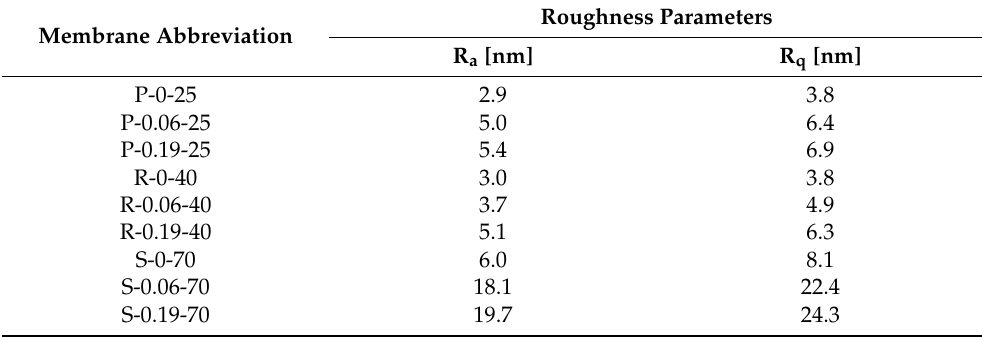
Table 4. Surface roughness parameters of the selective layer surface of PPSU and nanocomposite PPSU/O-MWCNT ultrafiltration membranes prepared at different coagulation bath